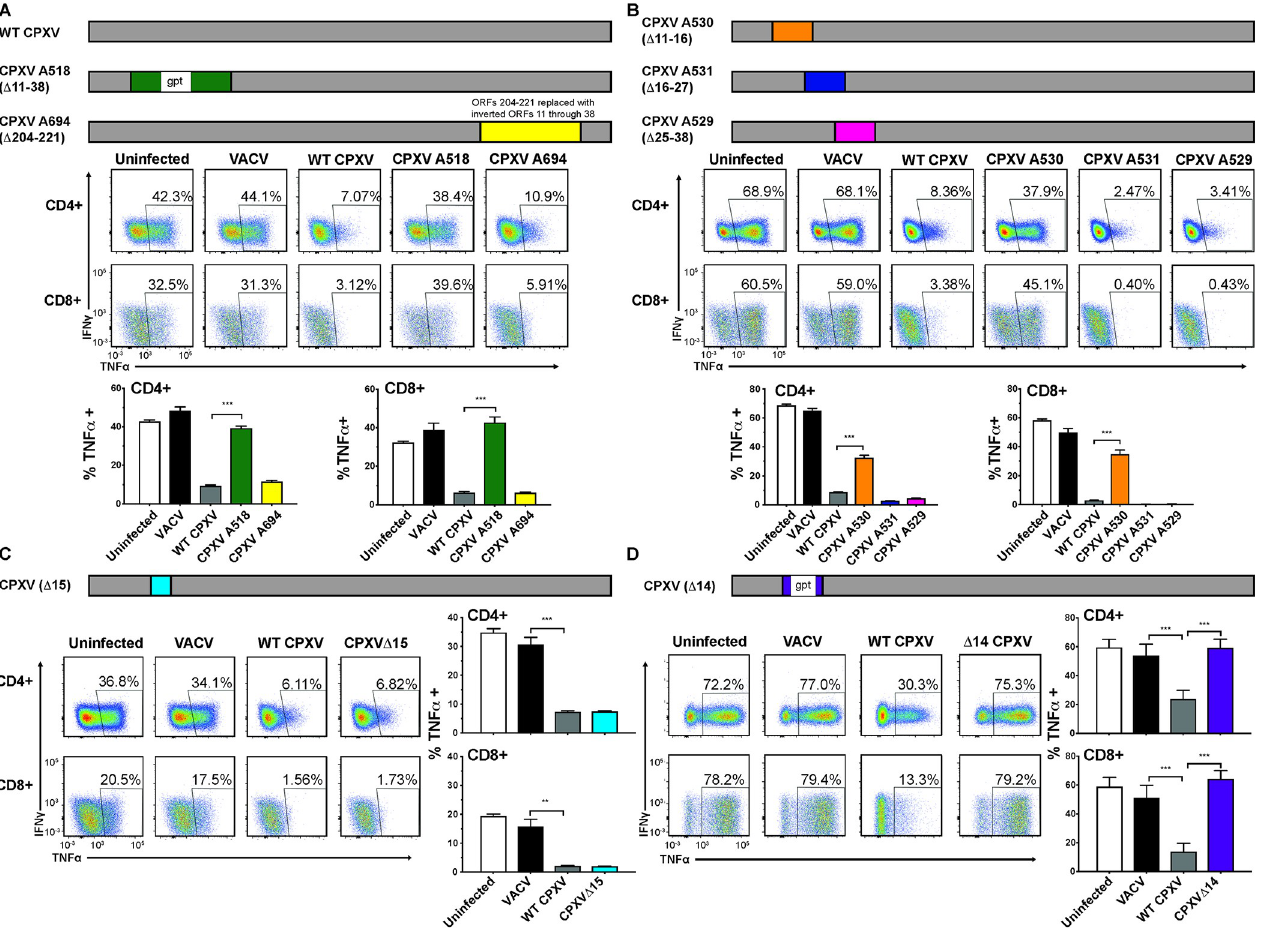
Fig 2. CPXV14 inhibits activation of na ï ve T cells by anti-CD3 and anti-CD28. A) A20 cells were infected with VACV, CPXV, or the two large deletion mutants A518 or A694 (MOI = 5), or uninfected and co-incubated with splenocytes from BALB/cByJ mice prior to α -CD3/ α -CD28 stimulation and ICS as described in Fig 1. Top: Schematic of the approximate size and location of the deletion, Middle: dot plot from a representative experiment. Bottom: Average frequencies of TNF α + CD4+ or CD8+ T cells (+SEM) within each experimental group (n = 5). B) A20 cells were infected with the deletion viruses A530, A531 or A529 (MOI = 5) or control viruses prior to co-incubation with splenocytes from BALB/cByJ mice, followed by α -CD3/ α -CD28stimulation and ICS. Bottom: Average frequencies of TNF α + CD4+ or CD8+ T cells (+SEM) within each experimental group (n = 5). C) A20 cells were infected with CPXV Δ 15, VACV or CPXV (MOI = 5), or uninfected prior to co-incubation with splenocytes from BALB/cByJ mice, α -CD3/ α -CD28stimulation and ICS. Right panel: Average frequencies of TNF α + CD4+ or CD8+ T cells (+SEM) within each experimental group (n = 5). D) CPXV Δ 14 was generated and characterized as shown in S2 Fig. A20 cells infected with CPXV Δ 14 or control viruses (MOI = 5) were co-incubated with splenocytes from BALB/cByJ mice followed by α -CD3/ α -CD28 stimulation and ICS. Right Panel: Average frequencies of TNF α + CD4+ or CD8+ T cells (+SEM) from two experiments each with n = 5 per experimental group. Indicated P-values were calculated using unpaired two-tailed Student’s T